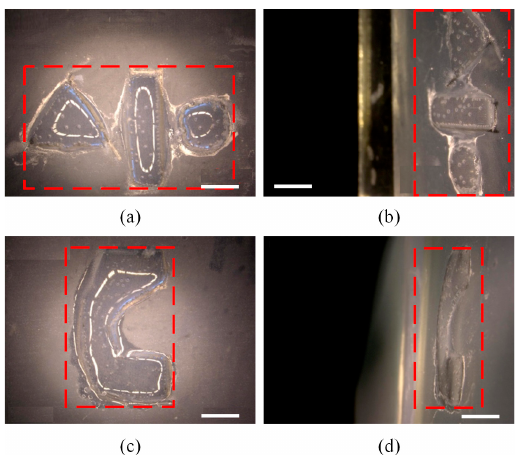
Figure 4. ( a ) Top view and ( b ) side view of hydrogel of triangle shape, rectangle shape and circle shape on one electrodeposition chip. ( c ) Top view and ( d ) side view of hydrogel of letter “C” shape. Hydrogel is framed by red dashed line. The scale bar is 2 mm.